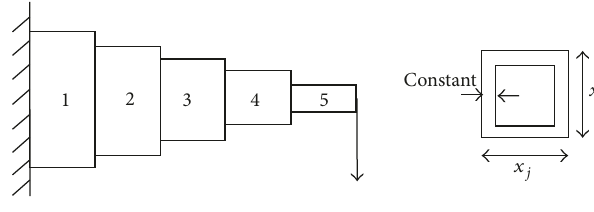
Figure 42: The cantilever beam design problem.